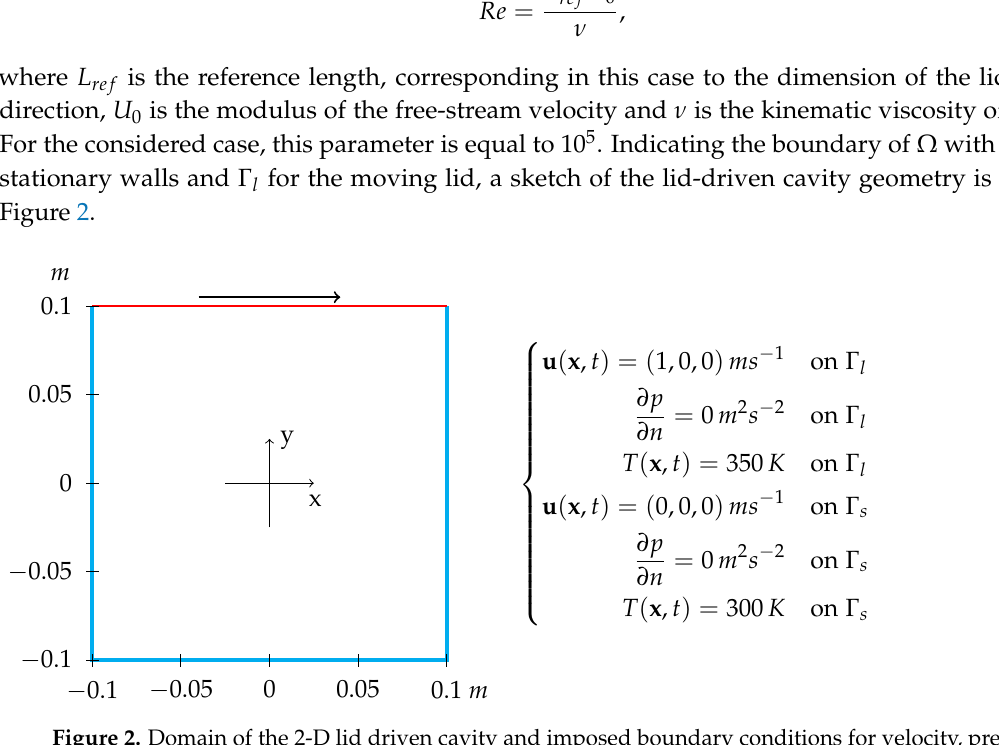
Figure 2. Domain of the 2-D lid driven cavity and imposed boundary conditions for velocity, pressure and temperature. The blue boundaries indicates the stationary walls, whereas the red one represents the lid moving in the positive x-direction. Dirichlet condition are imposed for velocity and temperature and a Neumann one is used for pressure. In the case without heat transfer, a Neumann condition is imposed also for